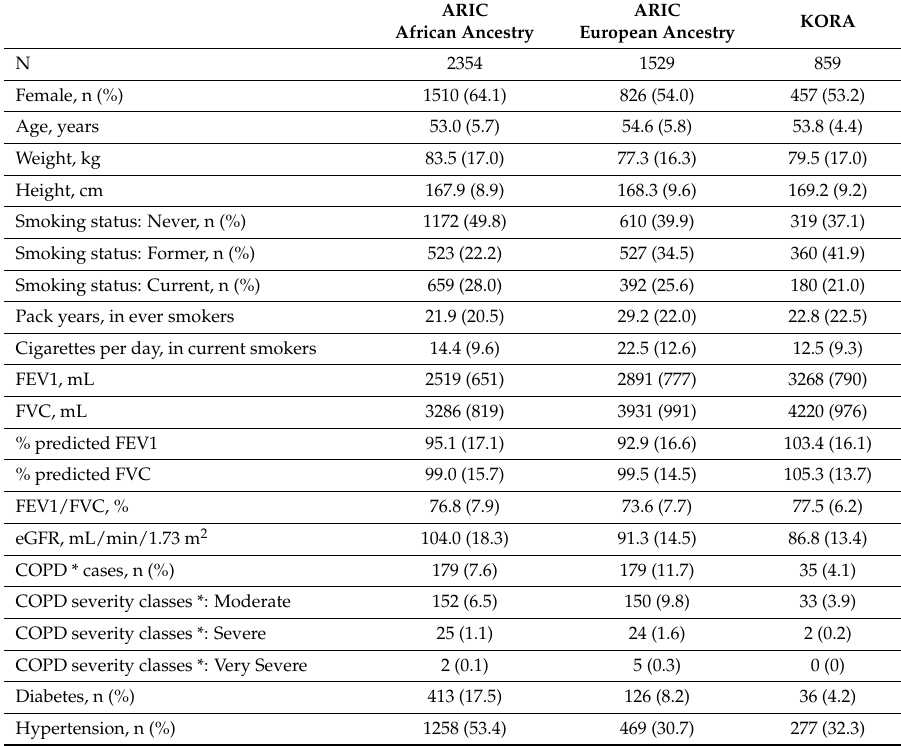
Table 1. Demographics for African and European ancestry from the Atherosclerosis Risk in Communities (ARIC) study and Cooperative Health Research in the Region of Augsburg